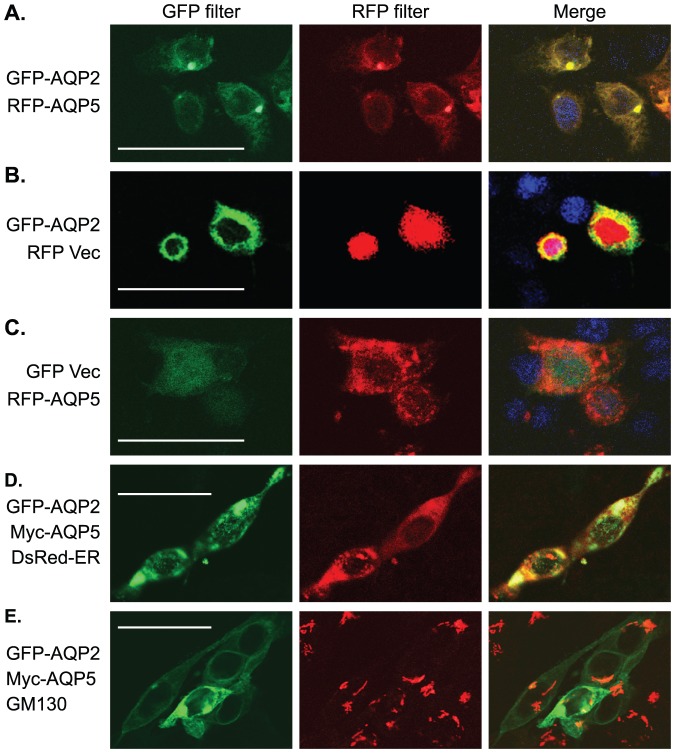
AQP5 and AQP2 colocalize and partially reside in the ER/Golgi compartments in IMCD3 cells.(A–C) Representative confocal microscopy images showing colocalization of RFP-AQP5 and GFP-AQP2 (A), lack of colocalization when GFP-AQP2 (B) and RFP-AQP5 (C) was coexpressed with RFP and GFP alone, respectively. (D) Representative confocal microscopy images showing AQP5-AQP2 complex partially locates in the ER in IMCD3 cells. IMCD3 cells were co-transfected with the plasmids as indicated and examined by confocal microscopy. DsRed-ER was used as an endoplasmic reticulum (ER) marker [39] and shown in red. GFP-AQP2 is shown in green. Myc-AQP5 was not directly detected, but can be inferred by its interaction and colocalization with AQP2 as large discrete foci seen in A. AQP2 alone seldom forms large discrete foci. In addition, more than 95% of transfected IMCD3 cells were always doubly transfected. Therefore, the presence of the large discrete foci is indicative of AQP2-AQP5 complex. (E) As in D except that DsRed-ER was omitted and cells were stained with an antibody specific for GM130, a cis-Golgi marker. Scale bar: 40 µM.